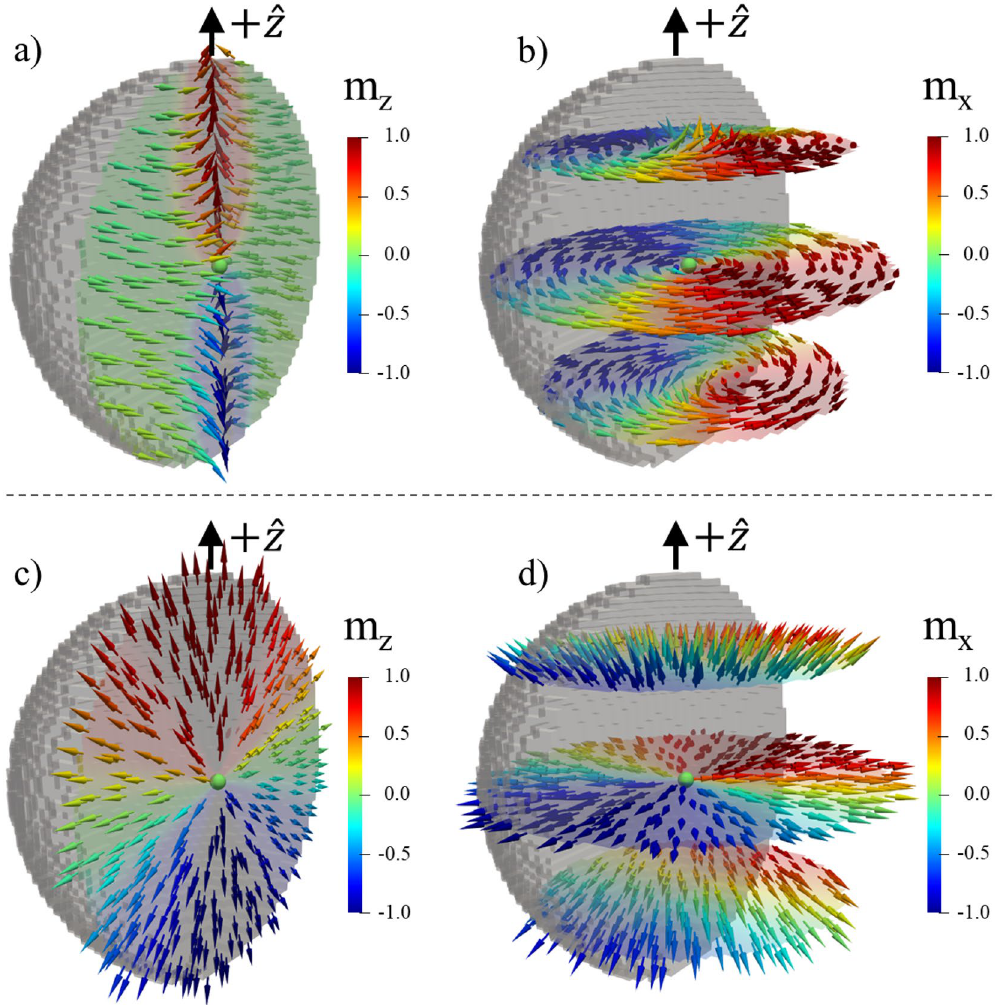
Figure 1. Simulated images of the Bloch points. (a,b) The spiral Bloch point (b) with the simulated inhomogeneous helicity γ( r ) and polarization p = + 1 in a spherical nanoparticle with radius R = 50 nm containing a Bloch point in the origin. ( c–d ) The radial hedgehog Bloch point with the helicity γ( r ) = 0 and polarization p = + 1. The magnetization configurations were obtained by micromagnetic simulations with parameters mentioned in the main text. The hedgehog Bloch point (c,d) was stabilized with no magnetostatic interactions. Magnetic configurations in the vertical (a,c) and transverse (b,d) cross sections are presented by arrows colored by the magnetization component indicated by the color